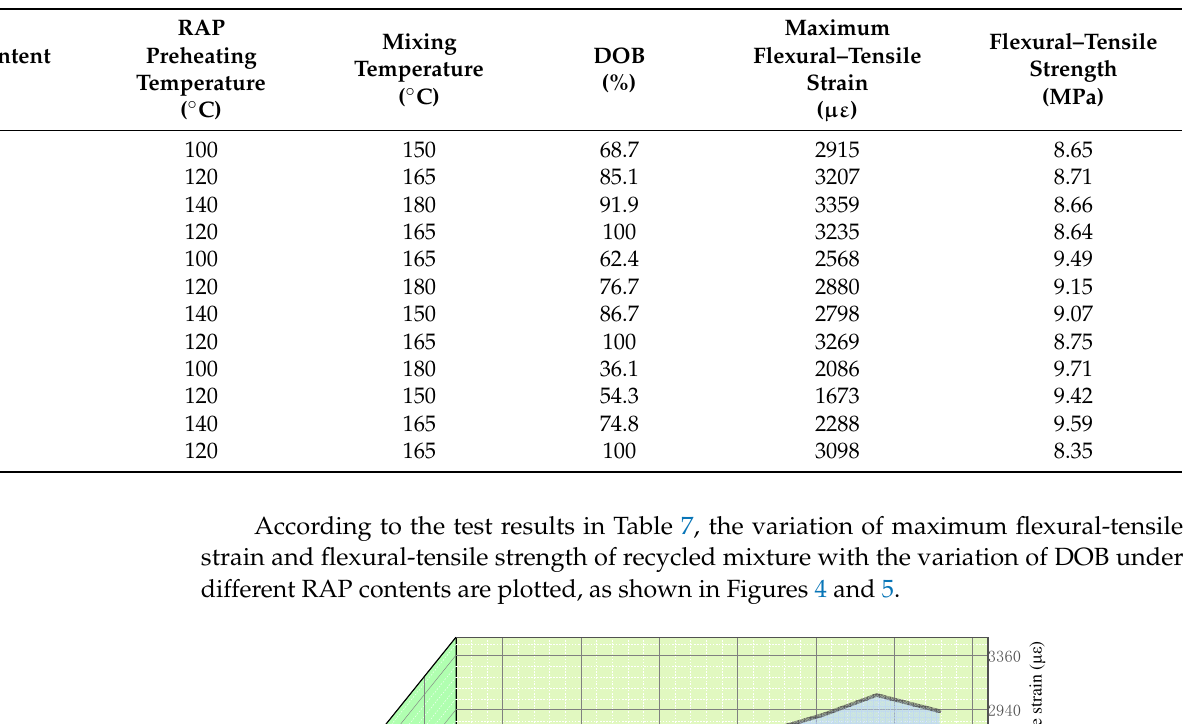
Figure 5. Variation of flexural–tensile strength with the variation of DOB under different RAP con- tents. From Table 7 and Figure 4, it can be determined that in the low-temperature beam test of the recycled mixture under three RAP contents, i.e., 30%, 40%, and 50%, the overall trend of the maximum flexural–tensile strain of the mixture increases by varying degrees with the increase of DOB. The higher the RAP content, the greater the maximum flexural– tensile strain’s growth rate. The reasons lie in the fact that when the miscibility state of old and new asphalt increases, the old asphalt in the recycled mixture is continuously stripped off from the surface of the old aggregate and then transformed into free asphalt. After being miscible with the new asphalt and regenerant, the old asphalt can restore to the new